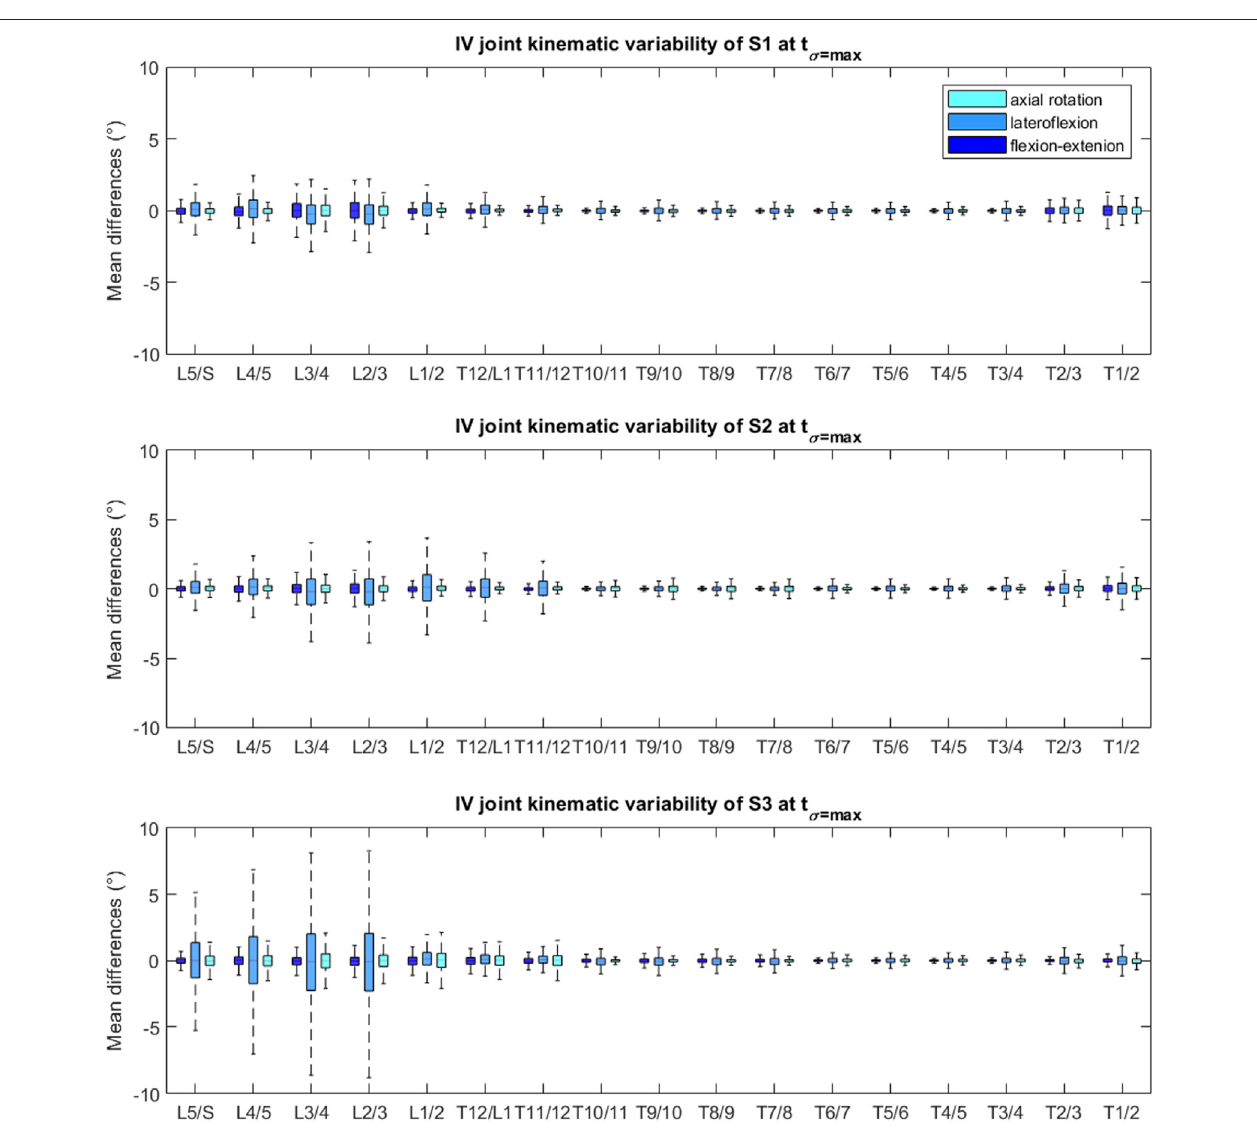
FIGURE5| Boxandwhiskerplotofthejointvaluesatt σ (cid:2) max ofeachDOF,relativetothebaselinemodel ’ sjointangles,foreachsubject.Theupperandloweredges oftheboxarethe75thand25thpercentiles,thehorizontalbarintheboxisthemedian(50thpercentile)andtheupperandlowerbarsaremaximumandminimumvalues.